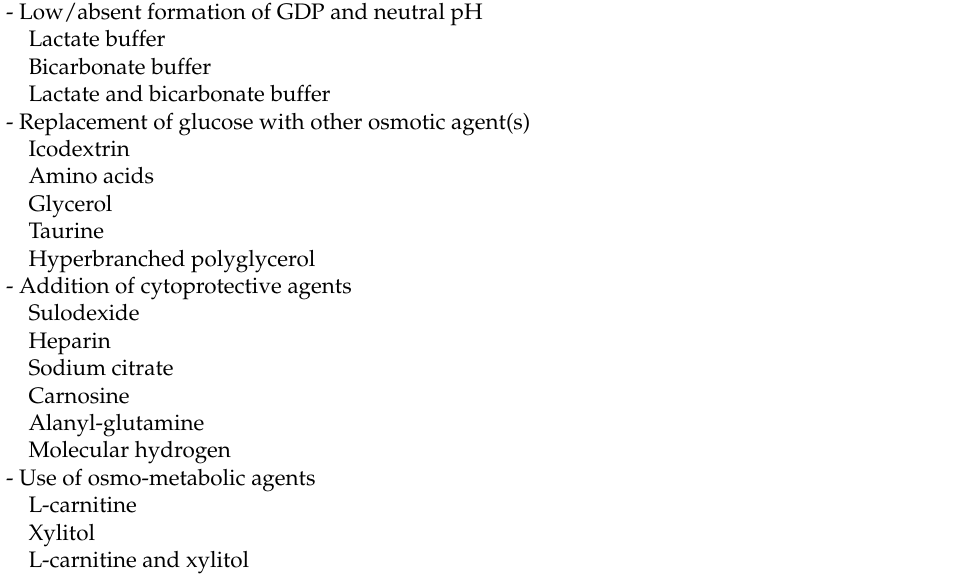
Table 1. Proposed strategies to improve the biocompatibility of standard peritoneal dialysis